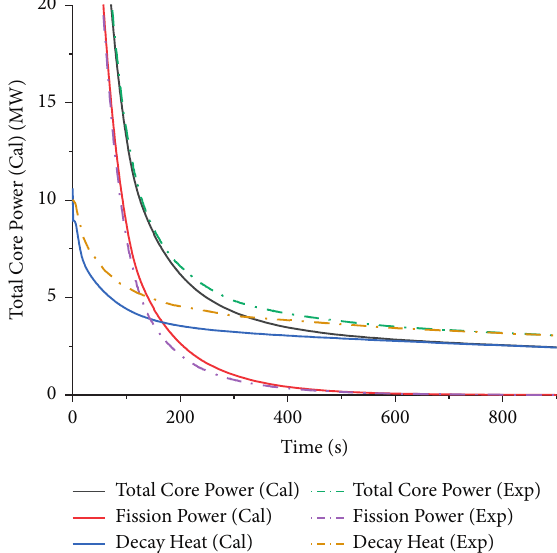
Figure 16: Reactor power of FFTF LOFWOS test #13 (low range).